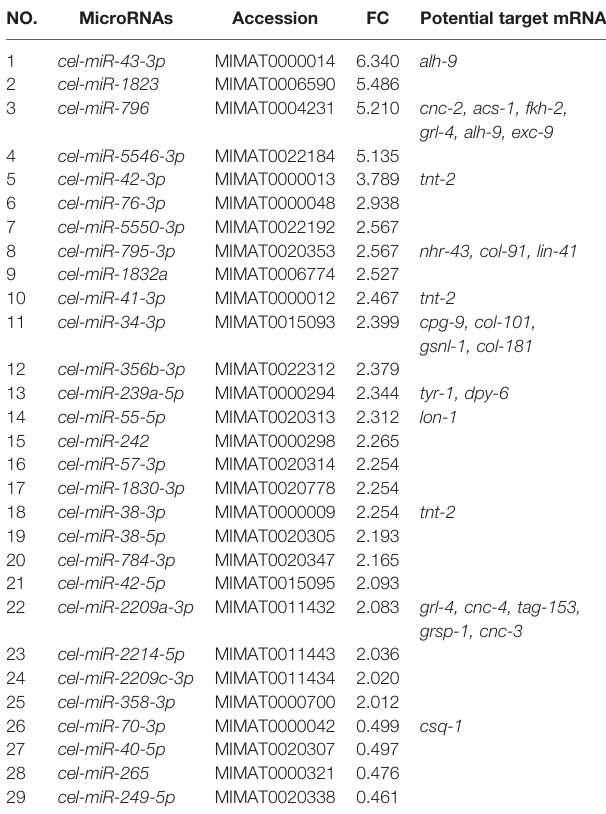
TABLE 1 | List of miRNAs that were signi fi cantly regulated in C. elegans exposed to LGG.